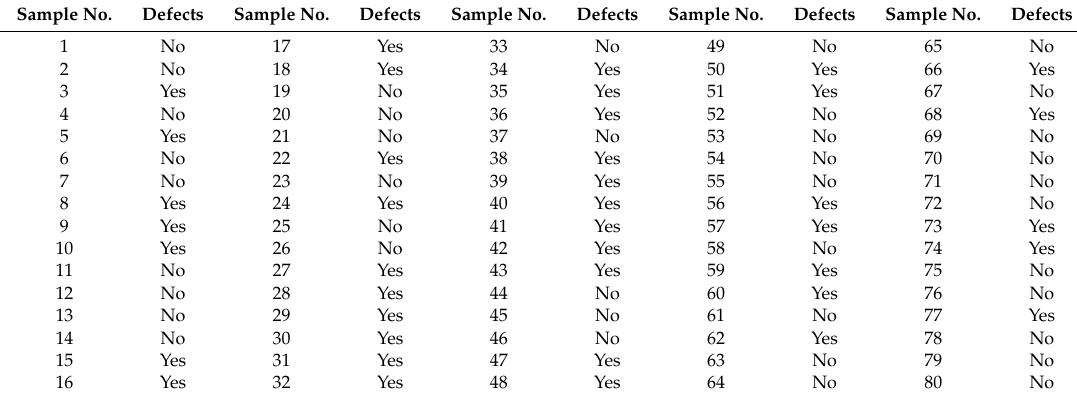
Table 3. Analysis of defect occurrence on the surface of individual